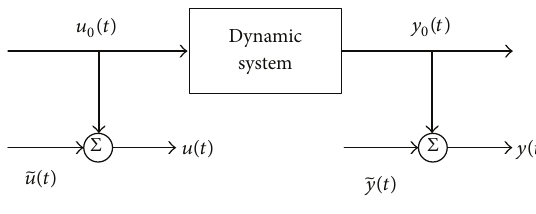
Figure 1: A basic errors-in-variables